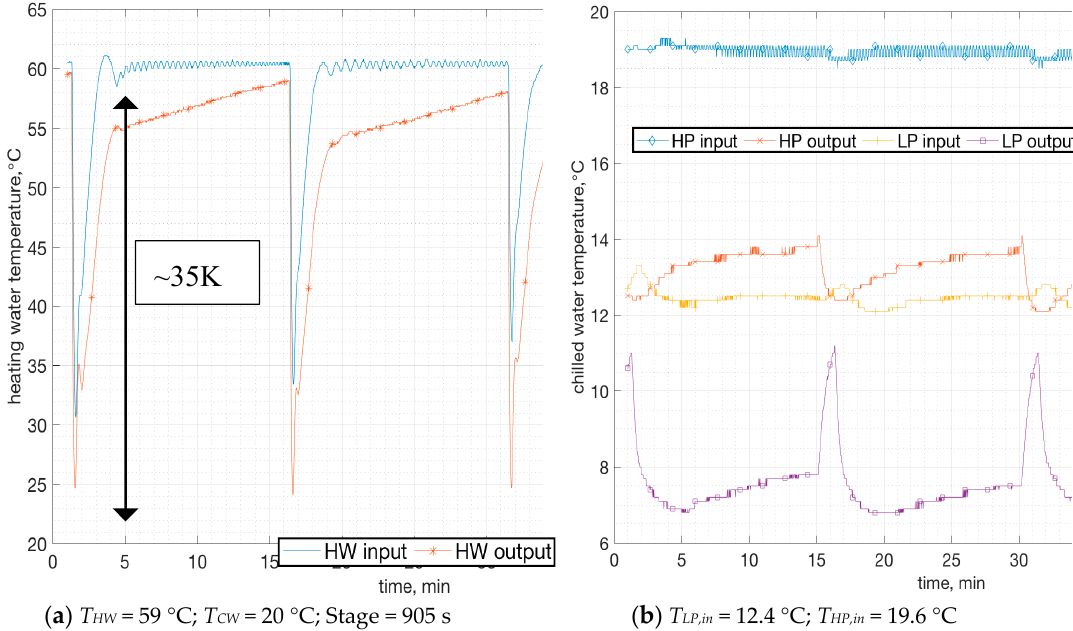
Figure 8. Examples of the inlet and outlet temperatures of the heating and chilled water registered during the operation of the chiller under the original control system. ( a ) and ( b ) were registered during the same time period. ( a ) Hot water inlet and outlet, ( b ) Low and high pressure.